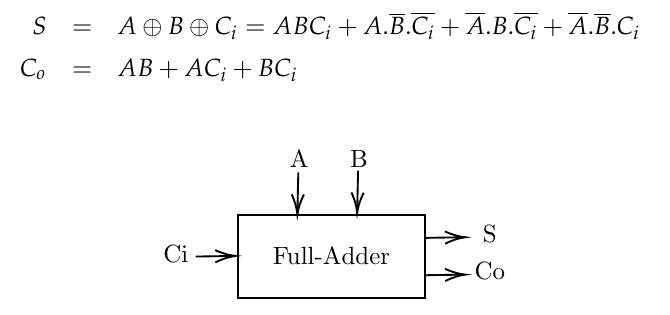
Figure 10. Single-bit full adder (FA)